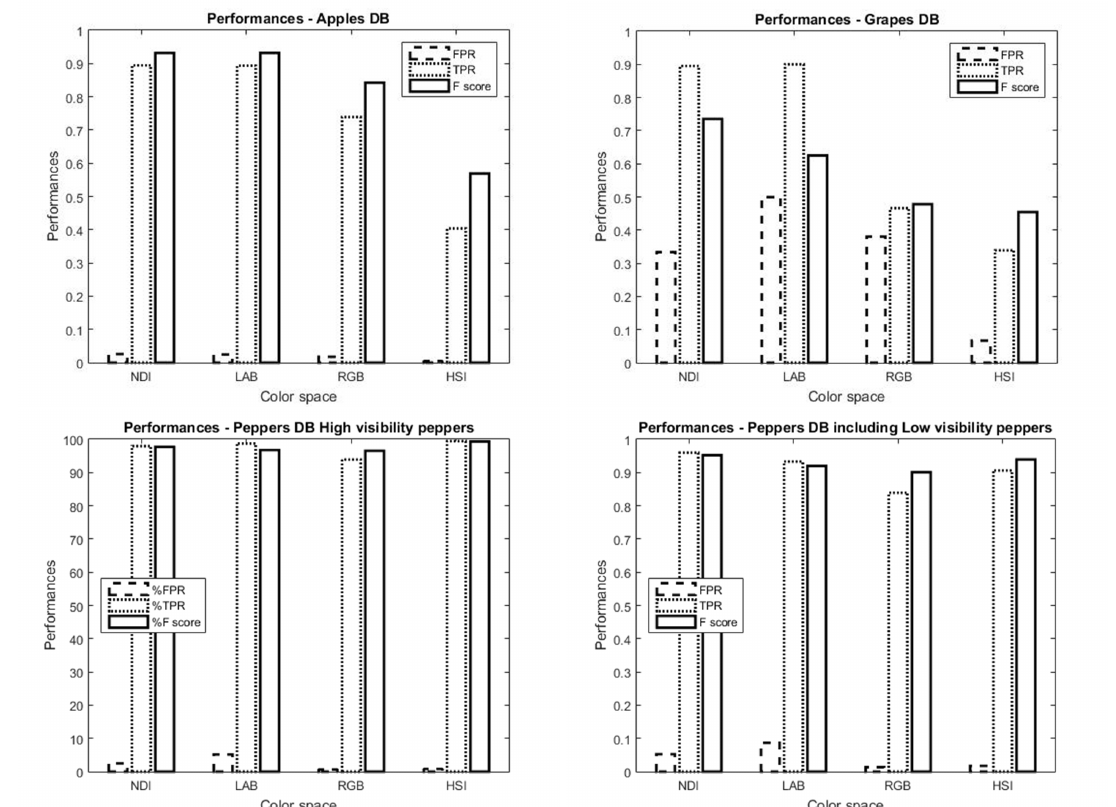
Figure 14. Color space performances for ( top ) apples ( left ), grapes ( right ), peppers ( bottom ) with high visibility ( left ), and peppers with low visibility ( right